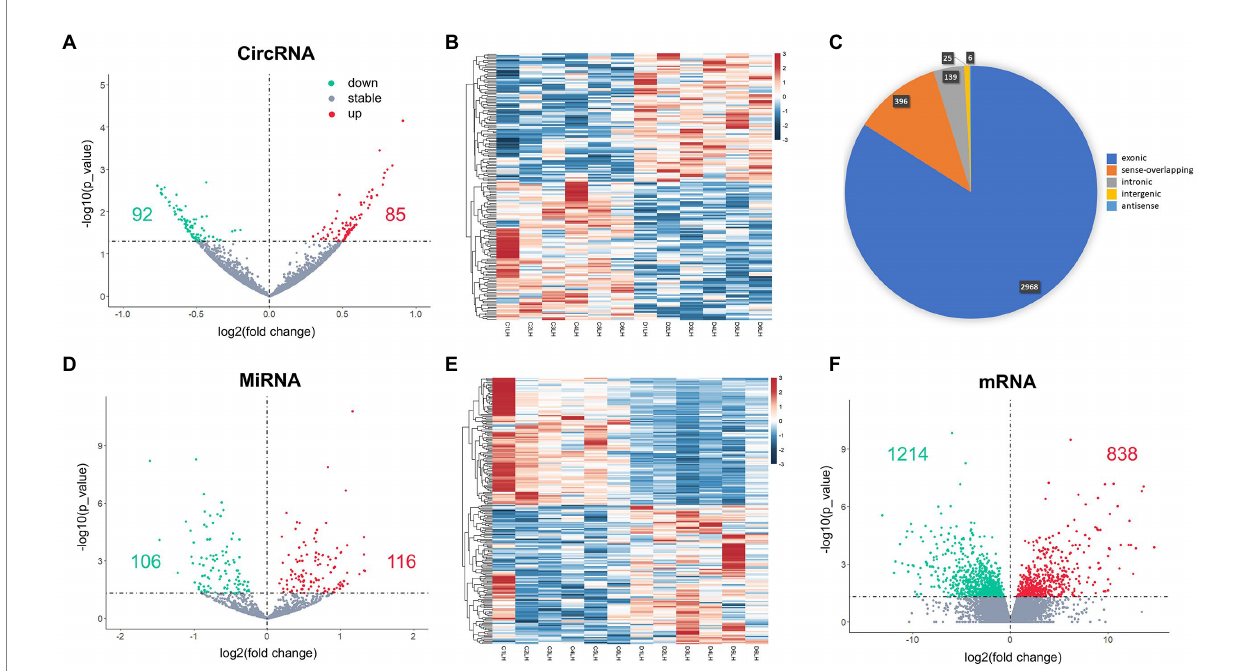
FIGURE 1 DEcircRNAs (A,B) , DEmiRNAs (D,E) and DEmRNAs (F) in the postoperative period. The classification of DEcircRNAs is shown as pie chart (C) . Red dots in volcano plots are up-regulated genes and green ones are down-regulated genes. Red rectangles in heatmaps are up-regulated genes and blue ones are down-regulated